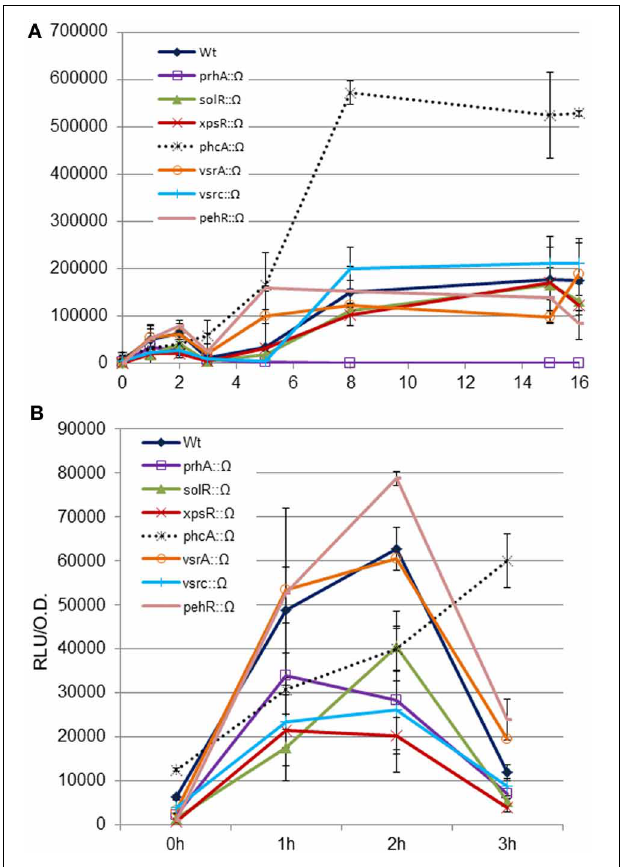
FIGURE 3 | Expression profiles of the hrpG promoter in wild type R. solanacearum or virulence regulatory mutants in co-culture with Arabidopsis cells. The wt or the prhA, solR, xpsR, phcA, vsrA, vsrC, and pehR disruption mutants carrying the PhrpG::LuxCDABE fusion were grown in Gamborg medium in the presence of plant cells and luminescence measured at different time points (A) . Zoom-in of hrpG expression during the first 3h of co-culture with Arabidopsis cells to better appreciate that all mutants show comparable expression profiles as the wild type in the first induction peak during growth in the presence of plant cells (B) . A representative result using three biological replicates is shown. Promoter output is presented as relative luminescence units (R.L.U) produced by the lux reporter corrected by cell density estimated by OD 600 . Error bars indicate standard